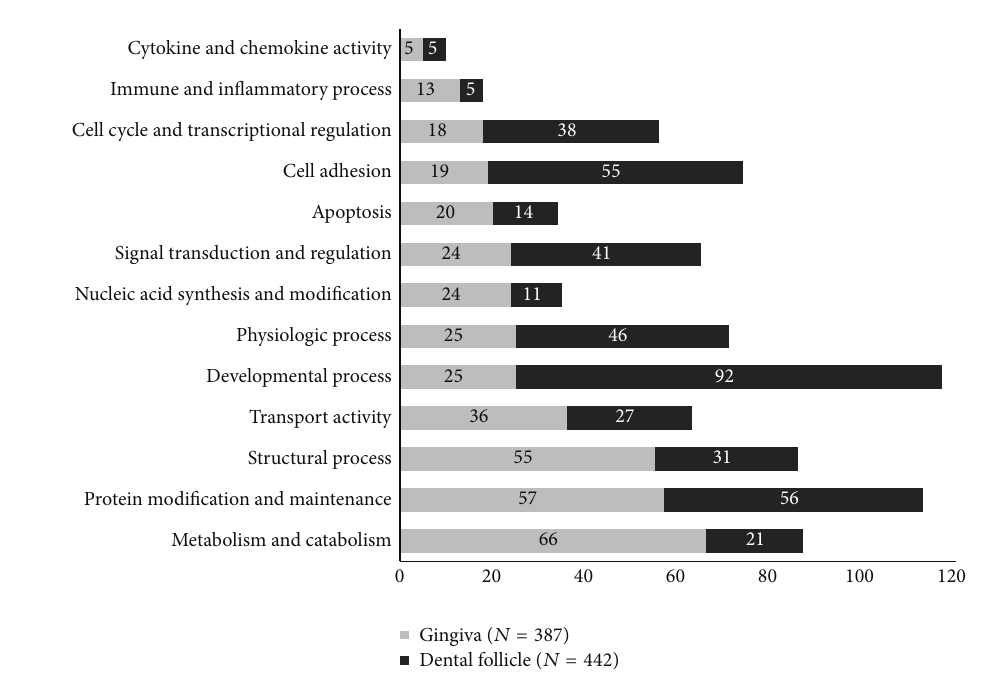
Figure 1: Main categories of genes expressed in the gingiva and dental follicles according to biological process. 𝑥 -axis: the number of involved